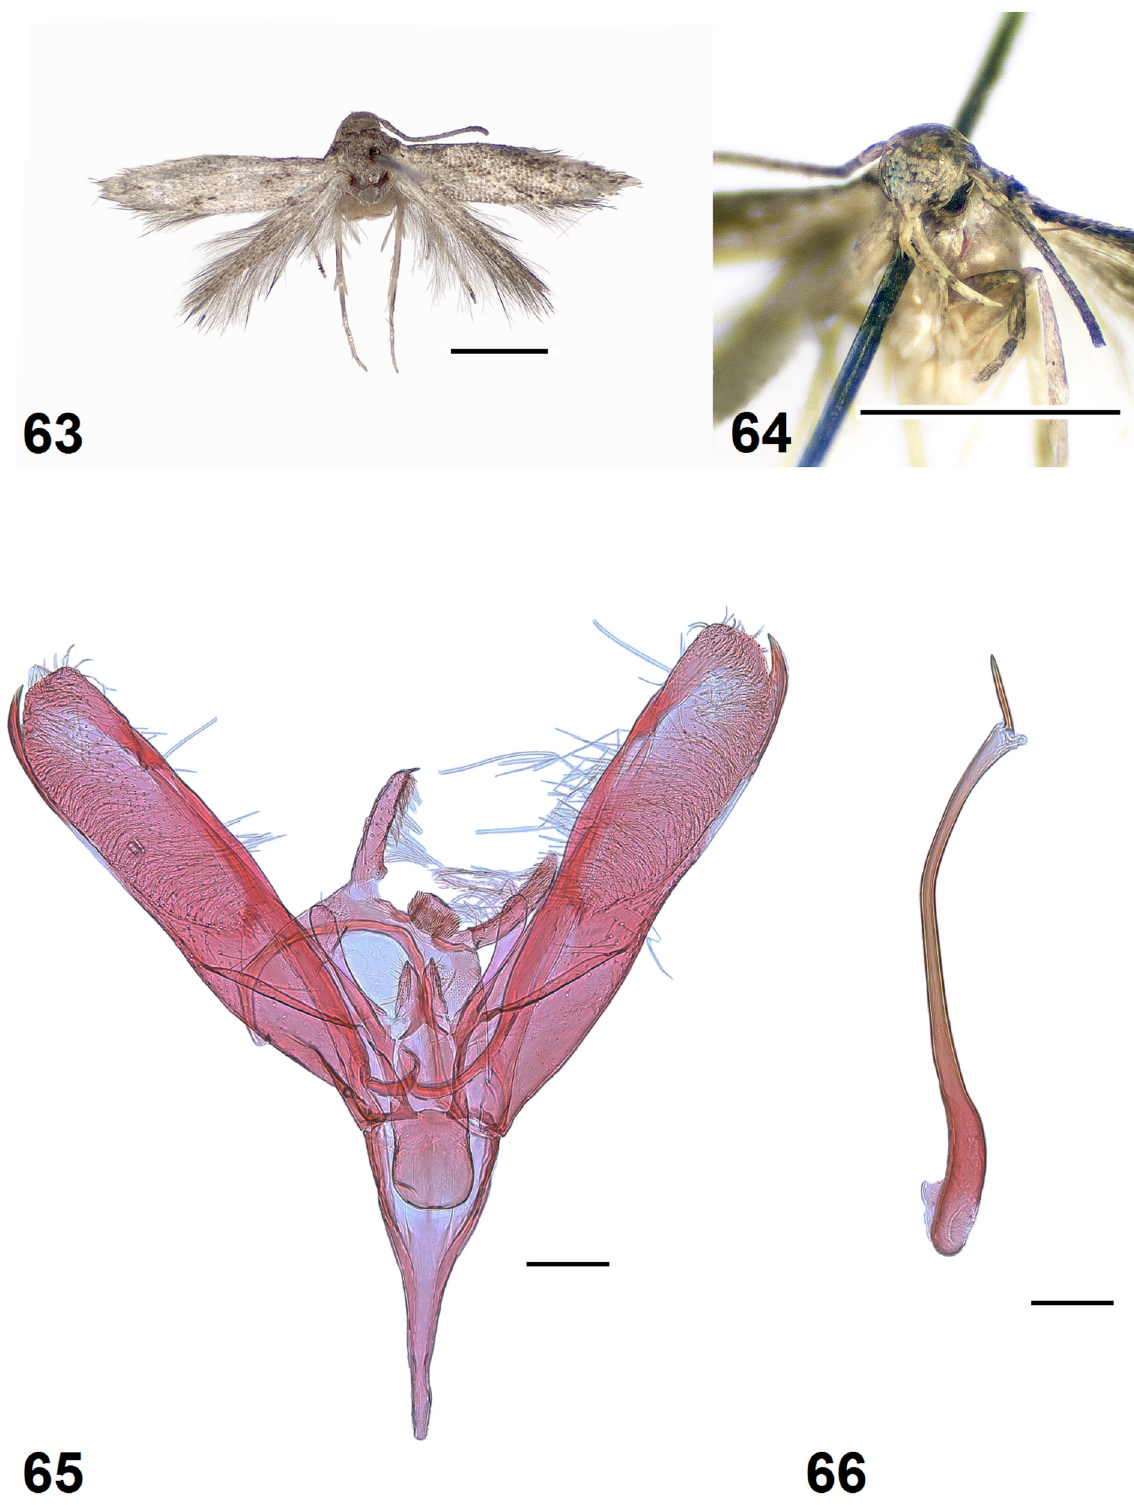
Figs 63–66. Elachista loeiensis Sruoga & Kaila sp. nov., holotype, ♂ (ZMUC 2073). 63 . Adult male. 64 . Head, latero-frontal view. 65 . General view of male genitalia (phallus removed). 66 . Phallus. Scale bars: 63–64 = 1 mm; 65–66 = 0.1